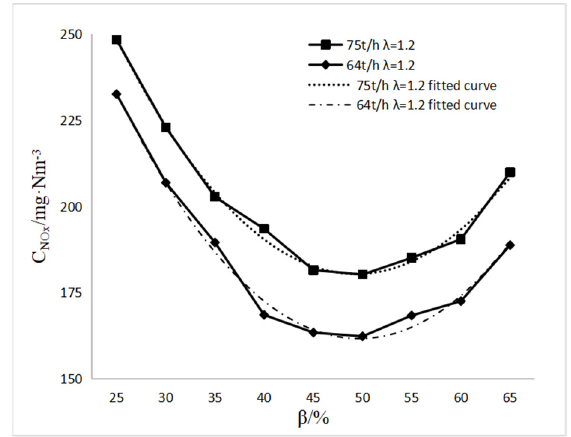
Figure 3. Effect of β on C NOx in the combustion flue